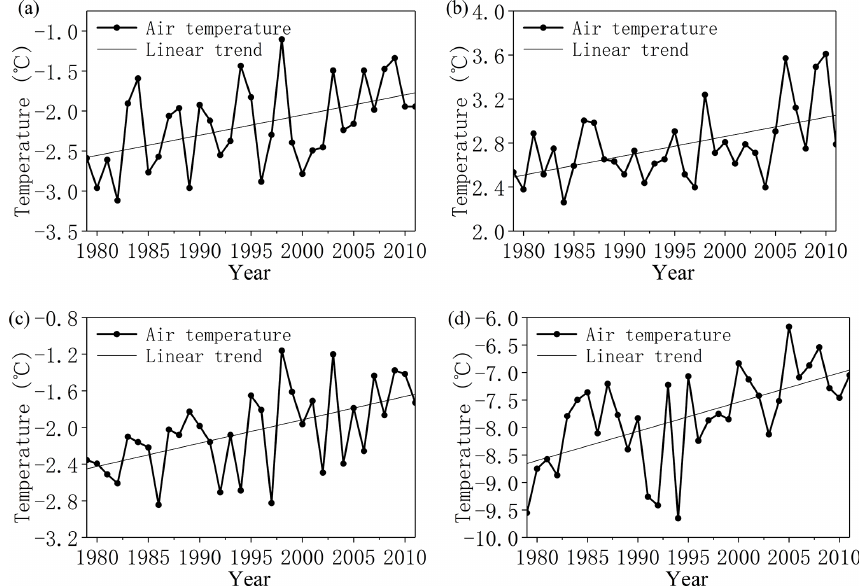
Figure 7. Variations in seasonal mean air temperature in (a) spring, (b) summer, (c) fall and (d) winter from 1979 to